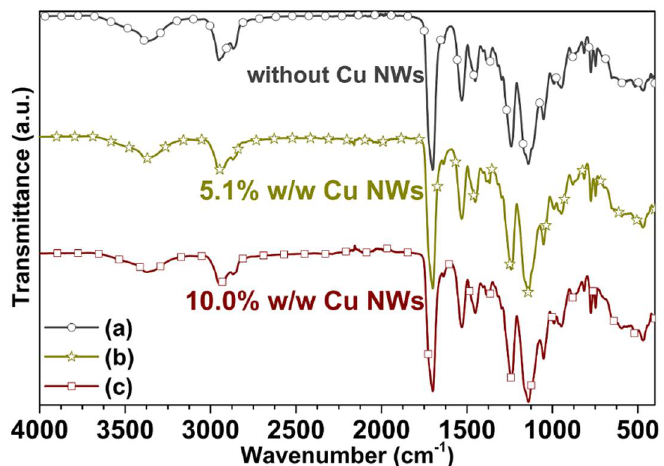
Figure 12. FTIR spectrums acquired on the substrates printed (a) without Cu NWs ( ◦ ), and with Cu NWs at (b) 5.1% w / w ( ∗ ), and (c) 10.0% w / w ( (cid:3)